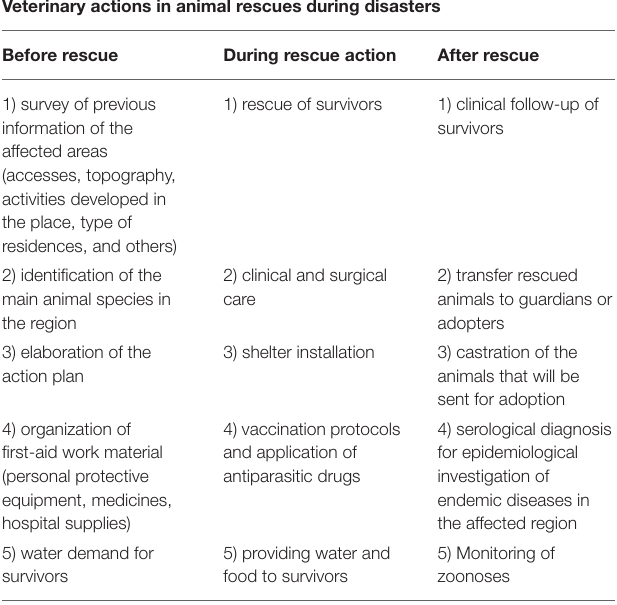
TABLE 2 | Main actions of rescue veterinary teams in cases of disasters. Veterinary actions in animal rescues during disasters Before rescue During rescue